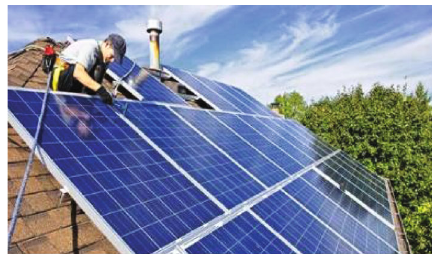
Figure 8: Polycrystalline solar panels